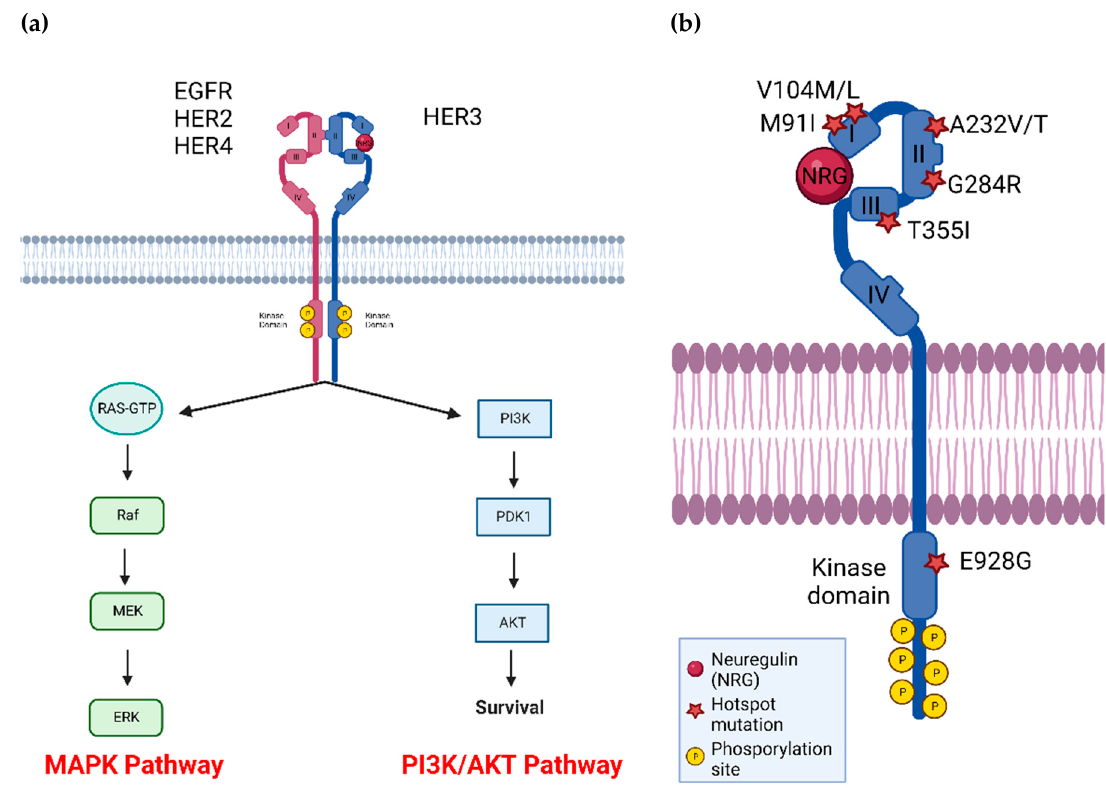
Figure 1. ( a ) HER3 dimerizes with other RTKs, most notably HER2, to activate downstream pathways involved in cell growth, survival, and signaling. ( b ) HER3 has several common mutations located across the four extracellular and kinase domains, as indicated by red stars. P: phosphorylation site, and NRG indicates the HER3 ligand neuregulin. Figure generated using BioRender.